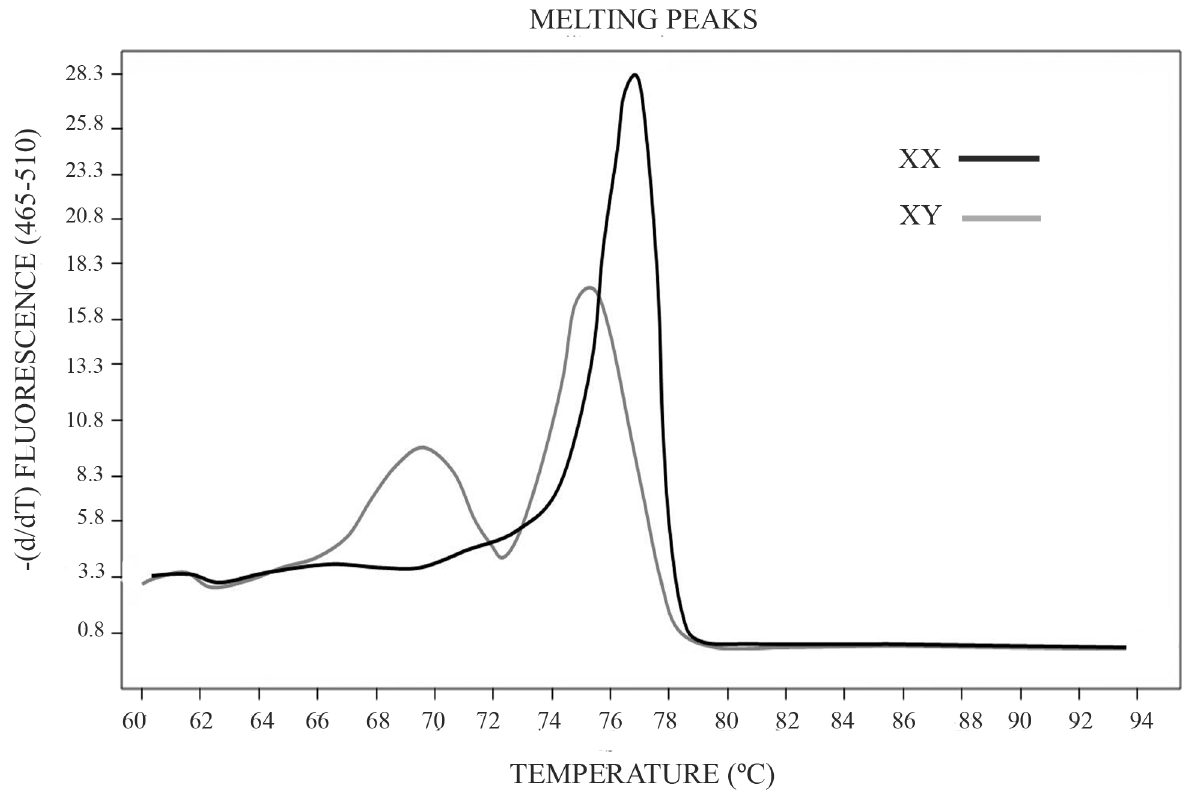
Figure 1. Melting temperature curve profiles produced by male and female samples in a HRM analysis. HRM analysis starts with a PCR amplification of the amelogenin gen. The amplification is in the presence of EvaGreen a saturating dye which presents high fluorescence when bound to dsDNA. Amplification is followed by a High Resolution Melting analysis (HRM) in the LightCycler 480 Real-Time PCR Instrument (Roche Applied Science). A dissociation curve analysis displays the different melting temperature of products from the X and Y chromosome.